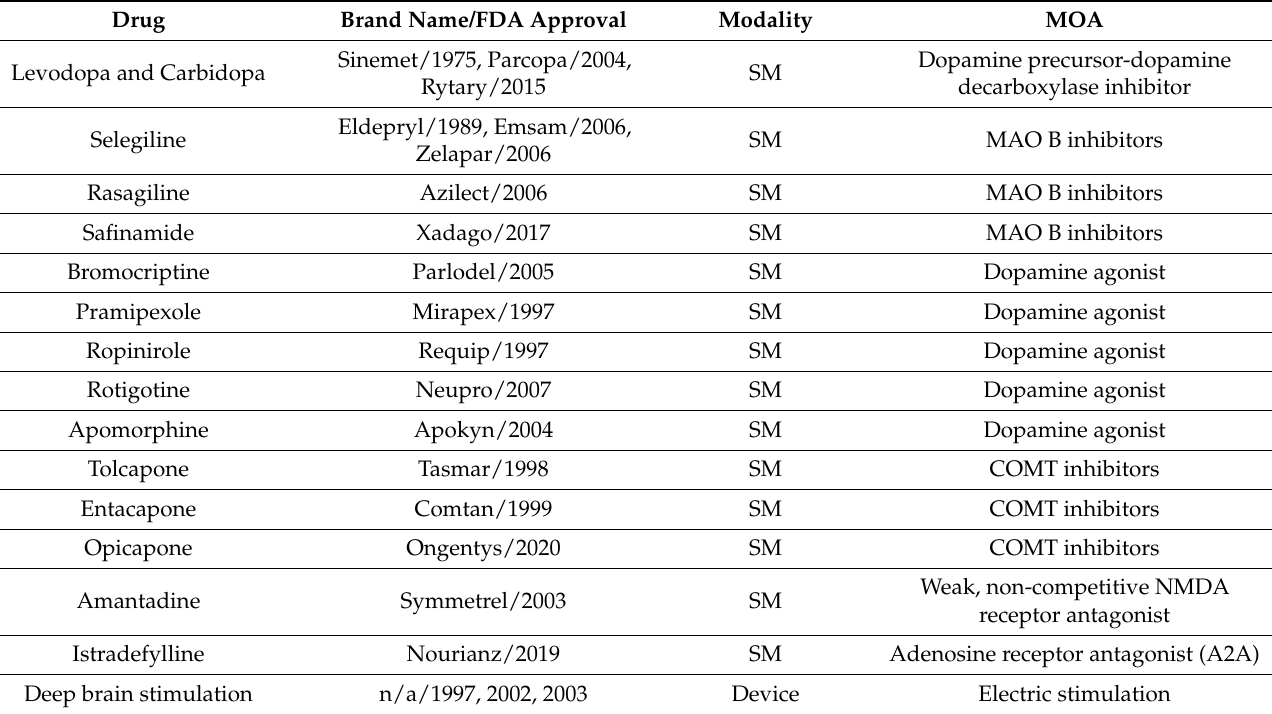
Table 14. Current therapeutics for